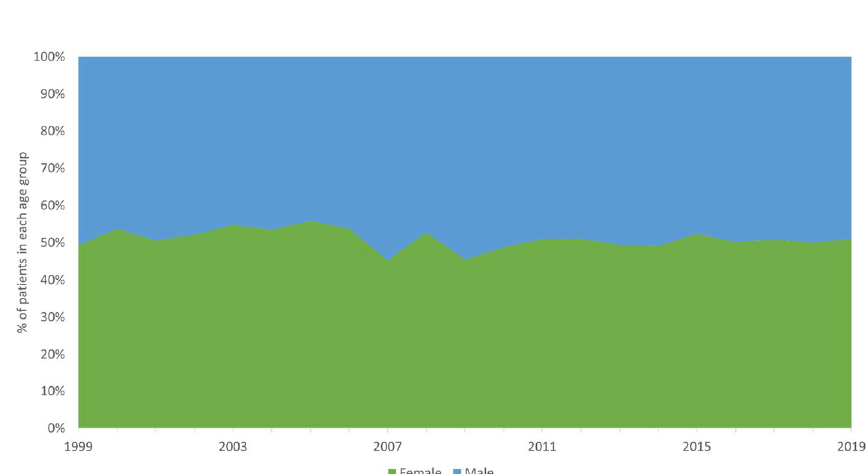
Figure 3. Male and female incidence rate for NMSC relation between 1999 and